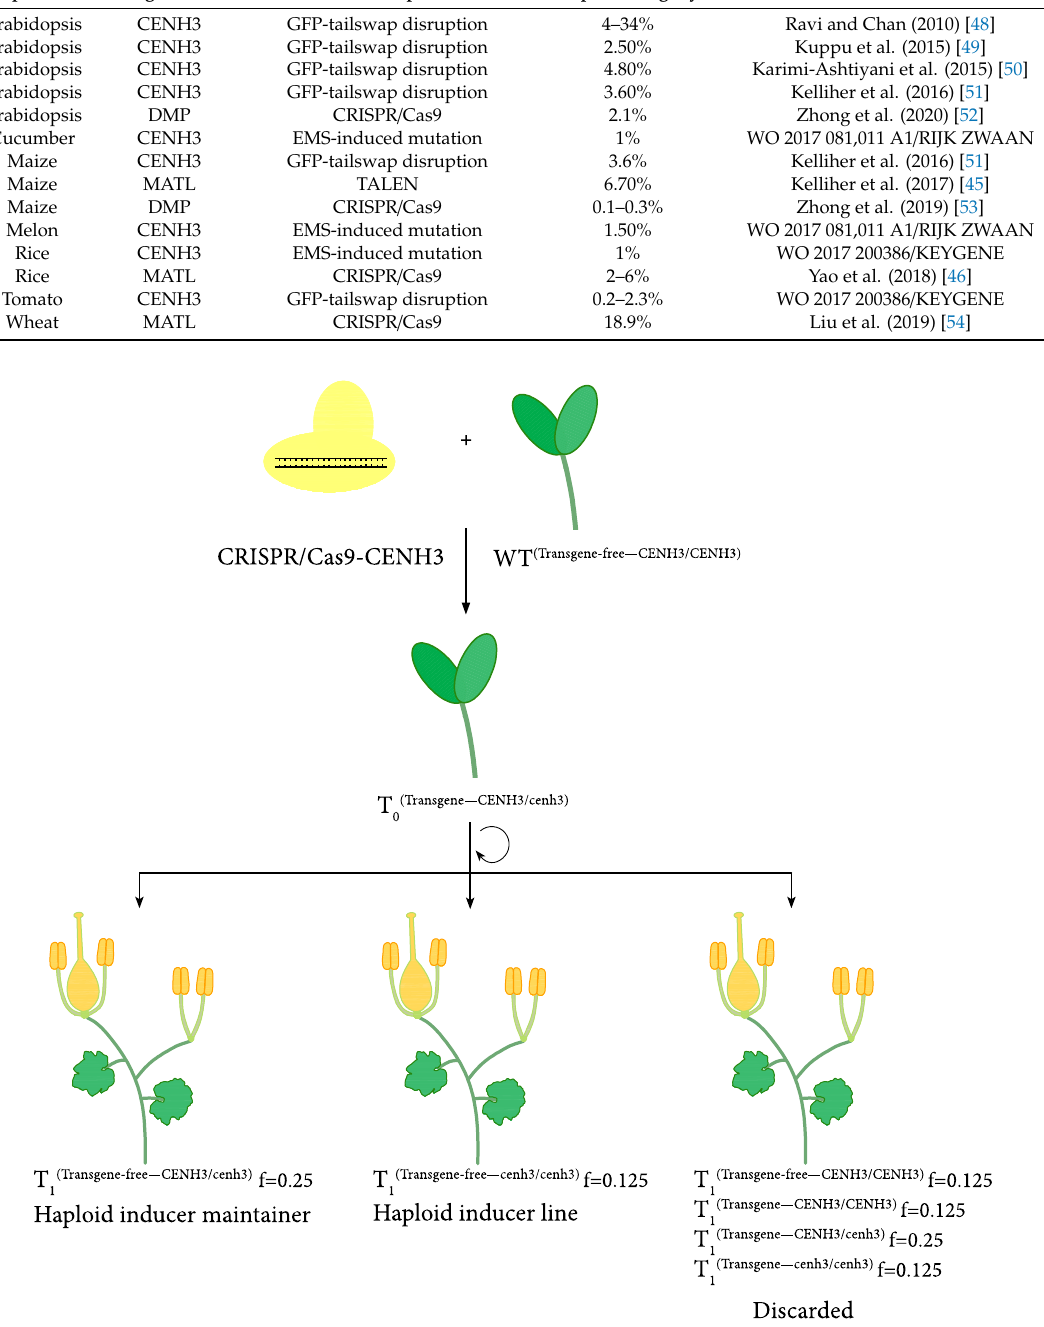
Figure 1. Schematic representation of the obtention of a haploid inducer line and its maintainer. WT: wild wild type.